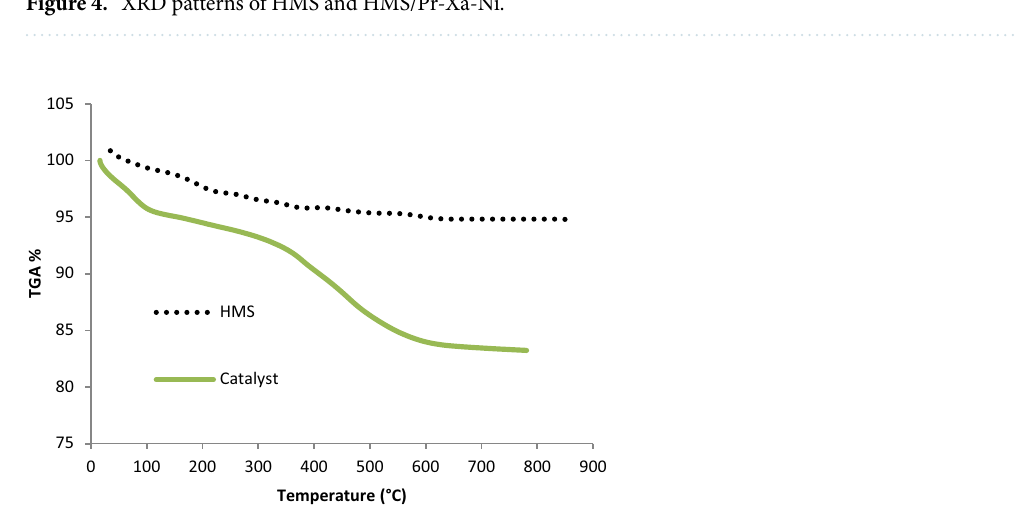
Figure 4. XRD patterns of HMS and HMS/Pr-Xa-Ni.